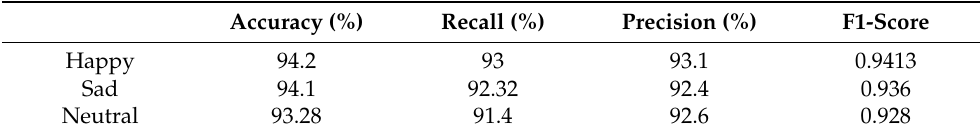
Table 8. Class-wise performance of the DCCA-based fusion method on MAHNOB-HCI dataset. Accuracy (%) Recall (%) Precision